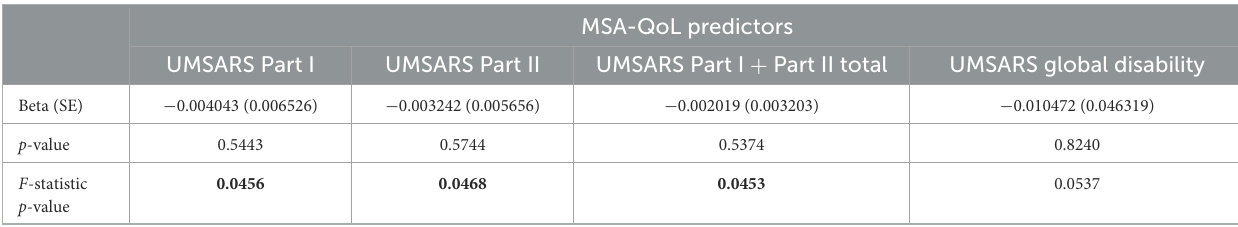
TABLE 6 Linear regression model results for MSA-QoL life satisfaction rating, with age as a